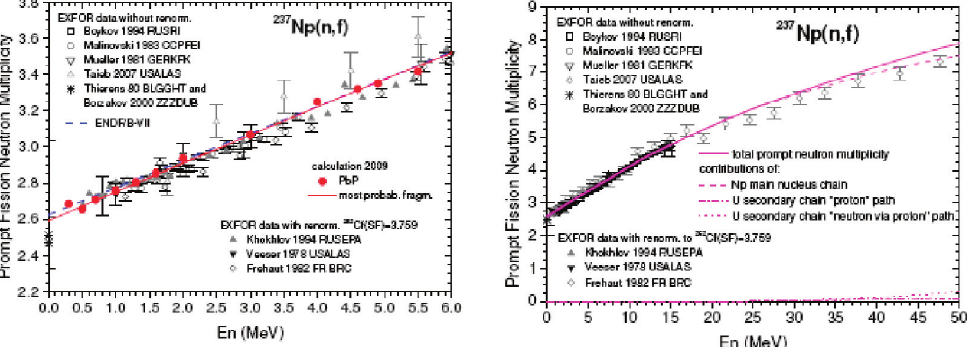
Fig. 5. Prompt neutron multiplicity calculation for 237 Np(n , f), left part up to 6, right part up to 50MeV incident neutron energy and compared to experimental